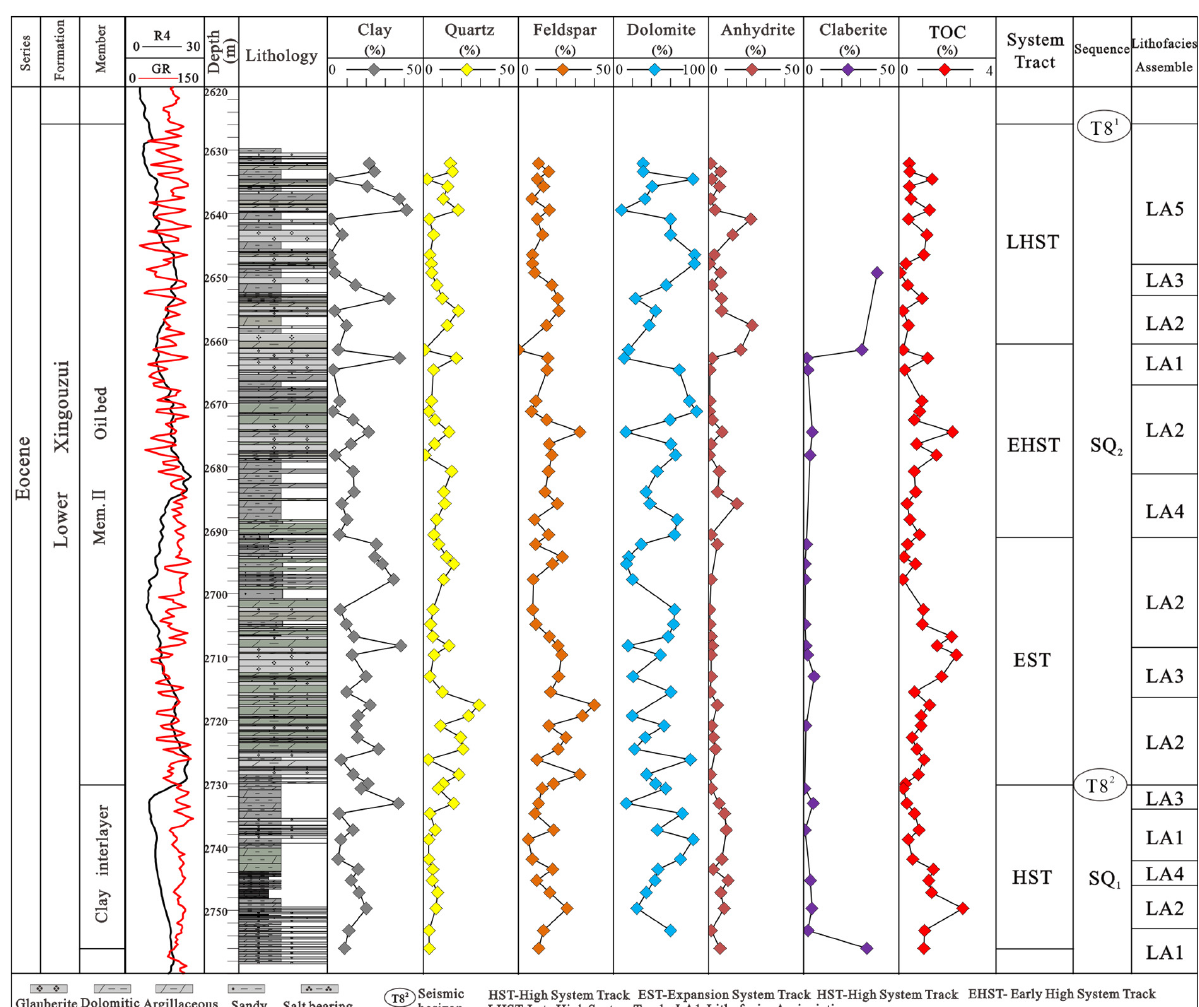
Figure 7. Sequence and lithofacies associations column of well CY1.